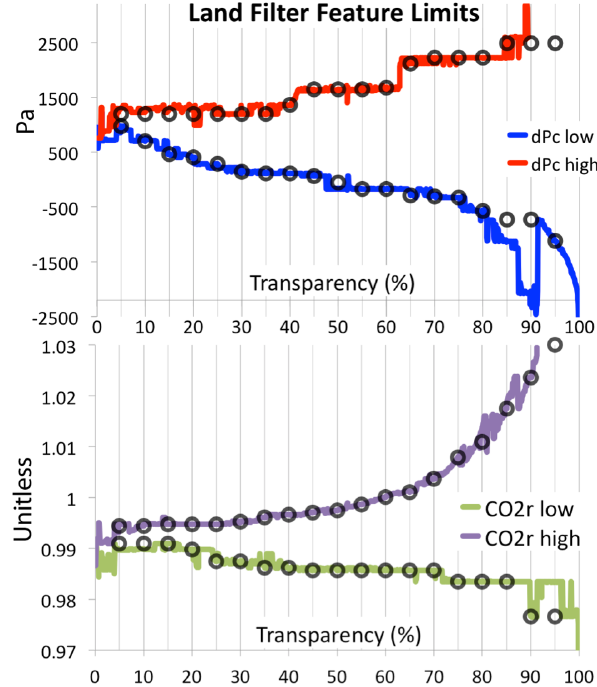
Figure 11. Land data sub-filter thresholds for dPc (top) and CO2r (bottom). Black circles 2 Fig. 11. Land data subfilter thresholds for dPc (top) and CO2r (bot- show monotonic, hand-smoothed final sub-filter values. 3 tom). Black circles show monotonic, hand-smoothed final subfilter